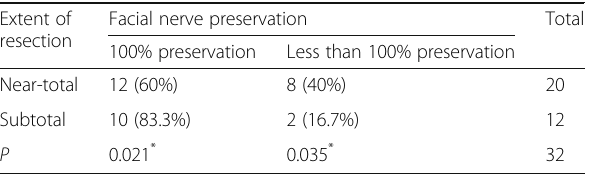
Table 4 Relation between the extent of resection and the functional preservation of the facial nerve Extent of Facial nerve preservation resection